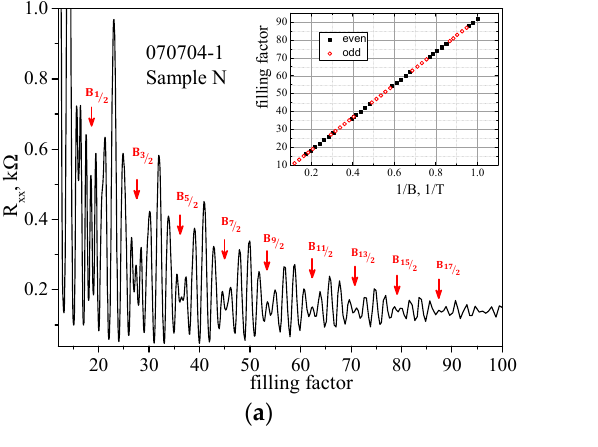
Figure 3. The oscillating part of R xx curves (shown on Figure 2) vs filling factor for Sample N ( a ) and 1/ B for Sample I ( b ). Node positions are denoted by the arrows. The numbering of nodes is indicated near the arrows. Insets: ( a ) Dependence of the oscillation minima positions in 1/B on the filling factor ν for Sample N. Filled squares denote even numbers; open circles denote odd ones. ( b ) Dependence of oscillation node positions in 1/B on its numbers N for Sample I.